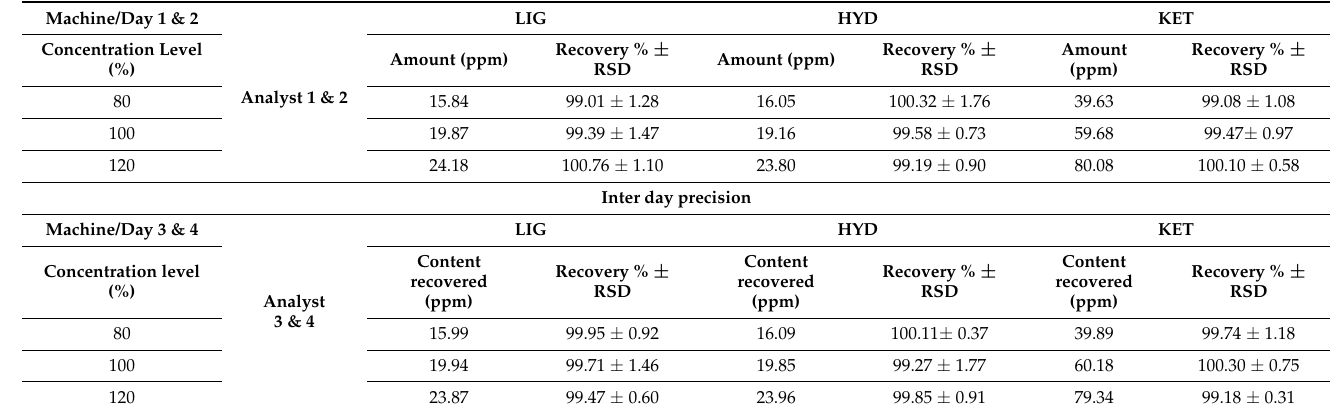
Table 4. Precision of the current HPLC method indicated at different days and analysts.